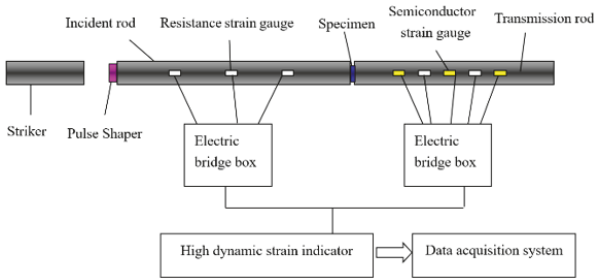
Figure 2: Diagram of the test device.